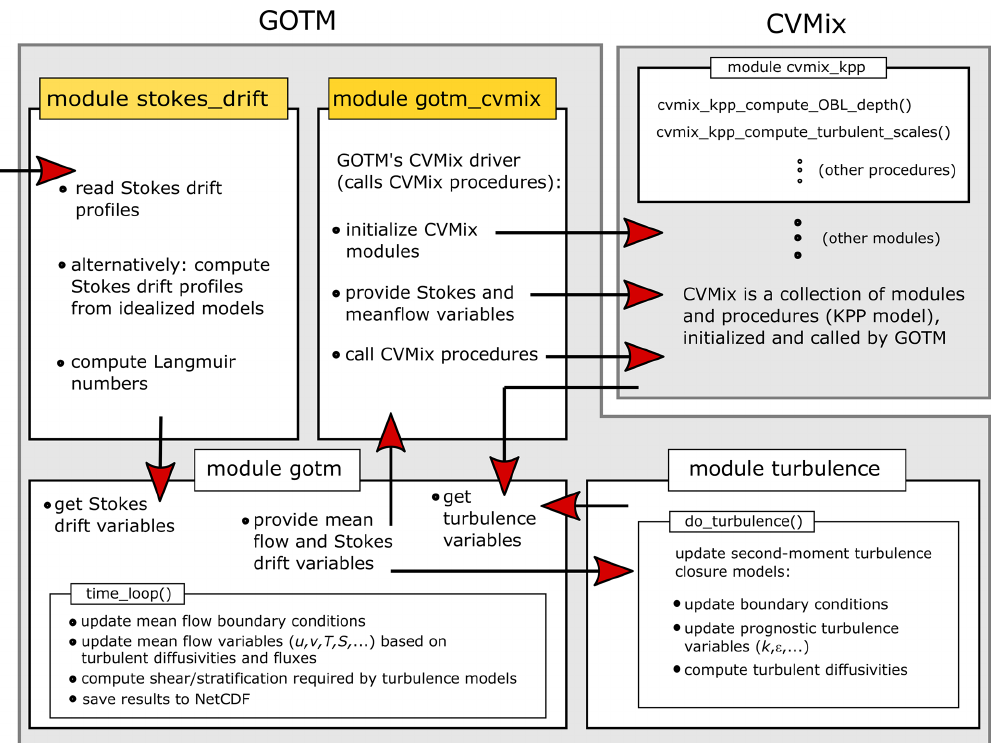
Figure 1. Schematic diagram illustrating the coupling of GOTM and CVMix. New GOTM modules are highlighted in yellow; interfaces between different model components are indicated as red arrows. Note that, for clarity, only a selection of the most relevant modules, procedures, and interfaces is